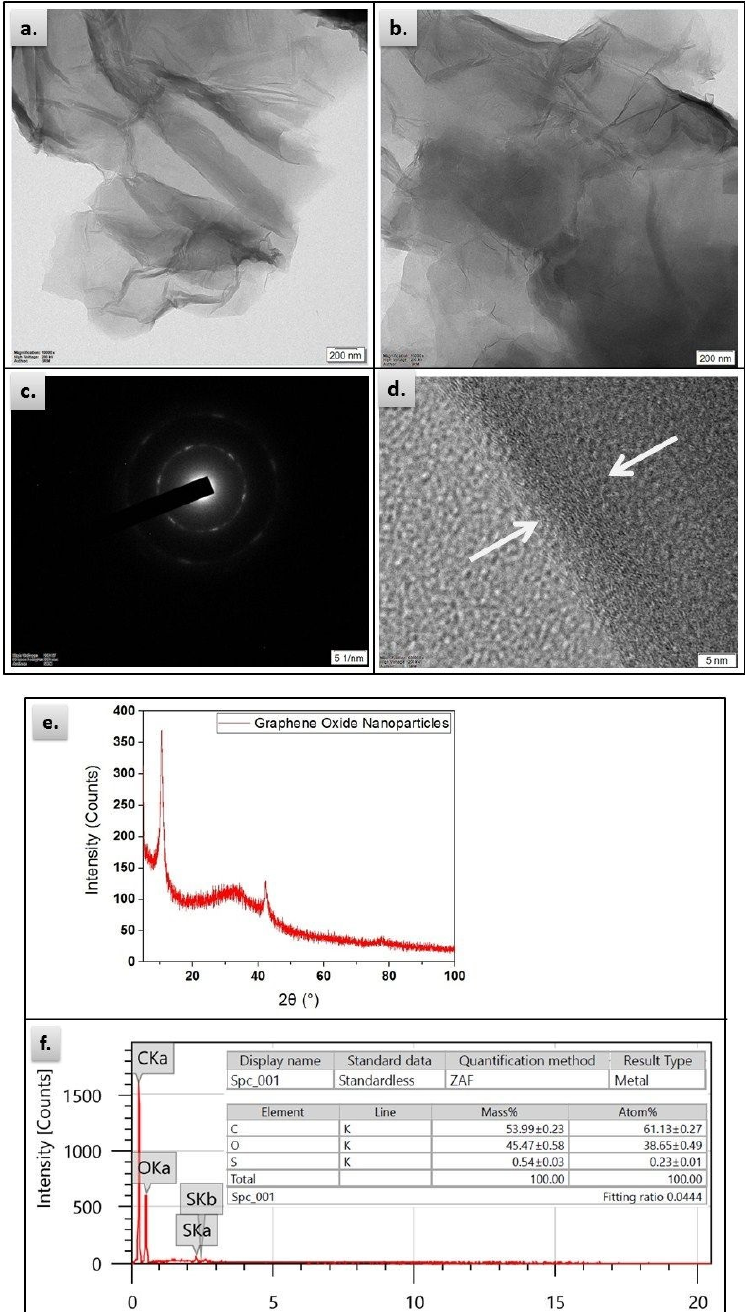
Figure 3. Characterization of GO powder: Transmission Electron Microscope (TEM) analysis at magnifications: ( a ) 1000 × ( b ) 1500 × ; ( c ) selected area di ff raction (SAED) pattern; ( d ) the edge area of the GO, indicating sheets consists of a few stacked atomic layers; ( e ) powder X-ray Di ff raction (XRD); and ( f ) energy dispersive X-ray (EDX)